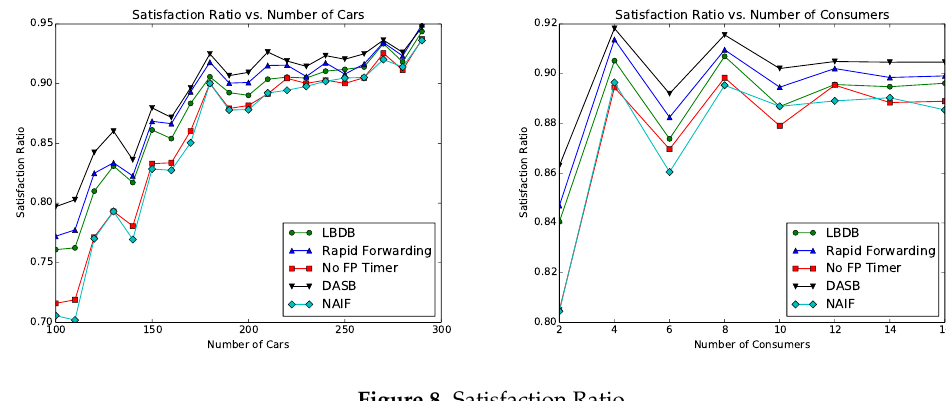
Figure 8. Satisfaction